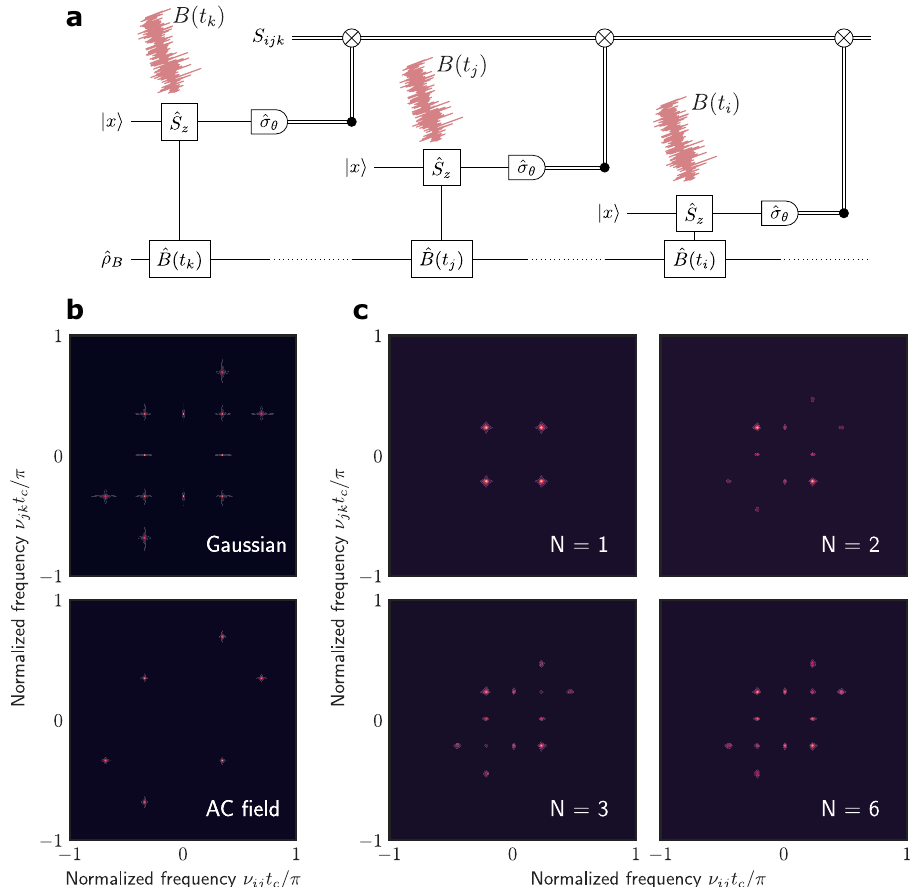
(cid:5) (cid:4) ν ν of ij , jk